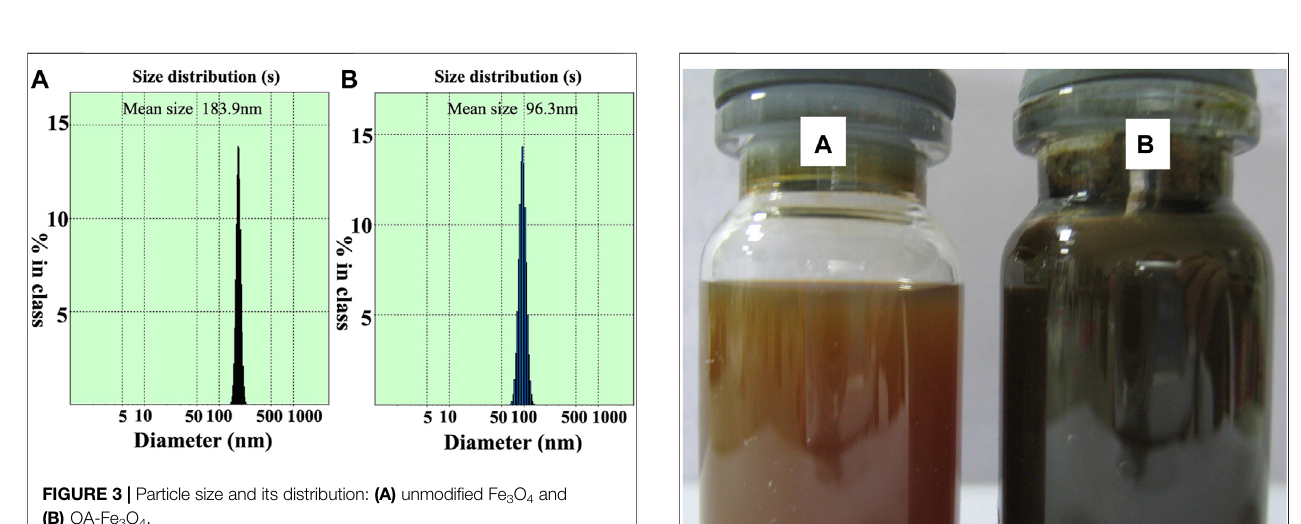
FIGURE 2 | Water contact angle of Fe 3 O 4 modi fi ed by OA with different dosages: (A) 0, (B) 0.5 wt%, (C) 1 wt%, and (D) 1.5 wt%.